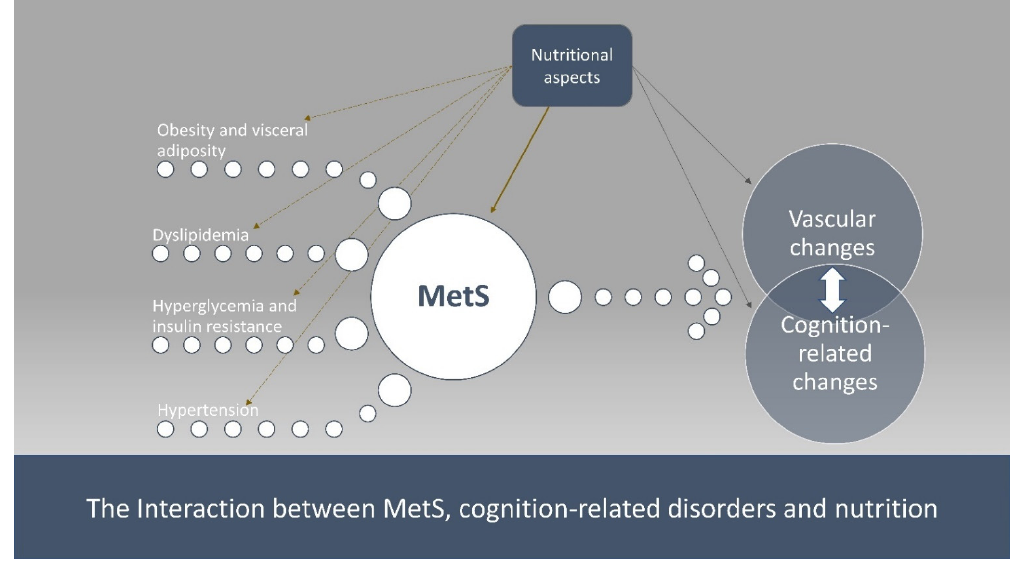
Figure 1. The interaction between MetS, cognition-related disorders and nutrition.